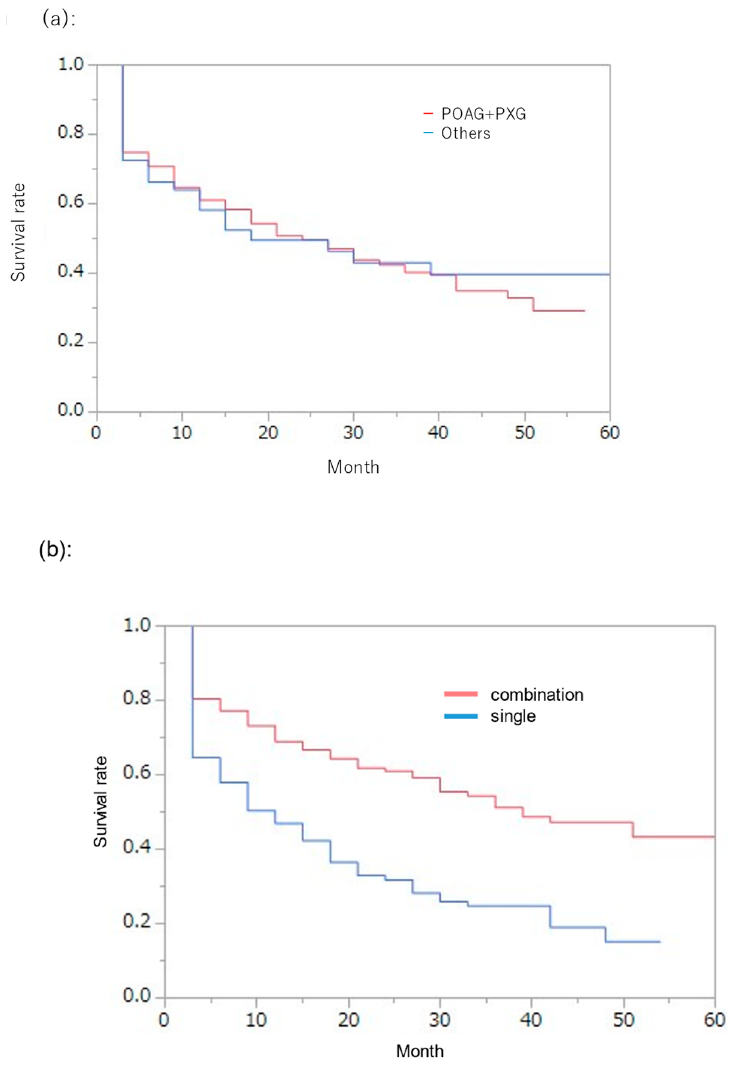
Figure 5. Comparison of survival curves between ( a ) type of glaucoma and ( b ) single vs. combination with cataract surgery in the quali fi ed success 2 de fi nition; Kaplan ‒ Meier method.